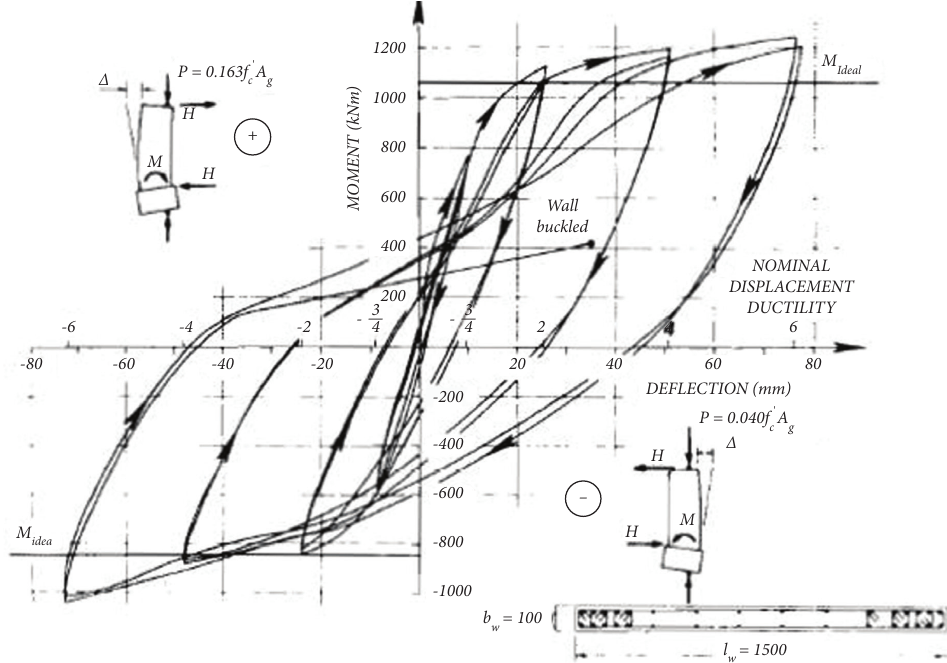
Figure 5: Definition of ductility considering positive and negative directions